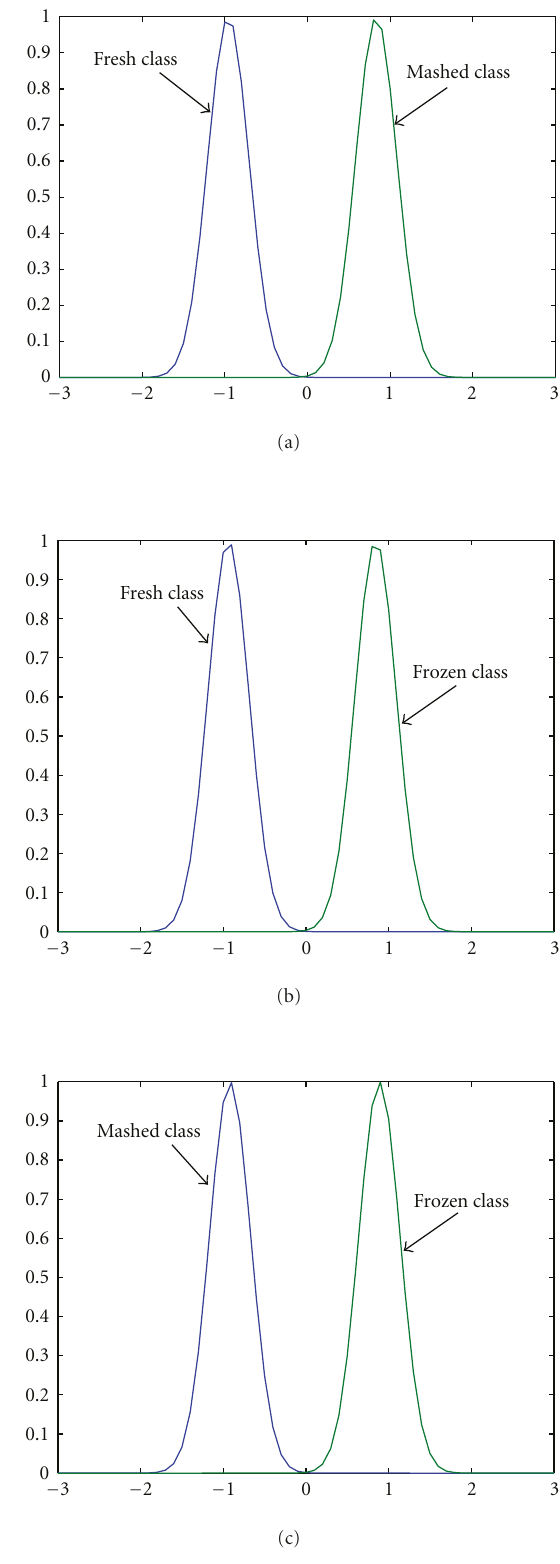
Figure 8: Output density functions for training phase of (a) fresh- pureed (shown as mashed) classes, (b) fresh-frozen classes, (c) pureed (shown as mashed)-frozen